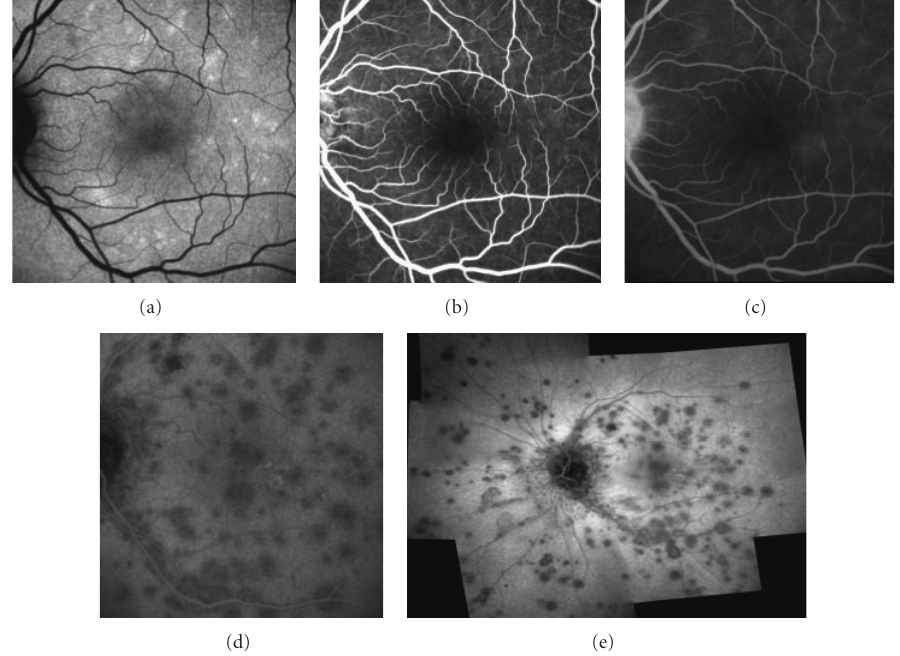
Figure 1: Initial presentation. (a) Fundus autofluorescence showing hyperfluorescent dots in macular area. (b) Early frame of fluorescein angiogram (FA) shows hyperfluorescent dots. (c) Late frame FA shows enlargement of hyperfluorescent lesion. (d) Late frame indocyanine green angiogram reveals hypofluorescent lesions. (e) Panoramic reconstruction of ICGA showing a great number of hypofluorescent lesions.